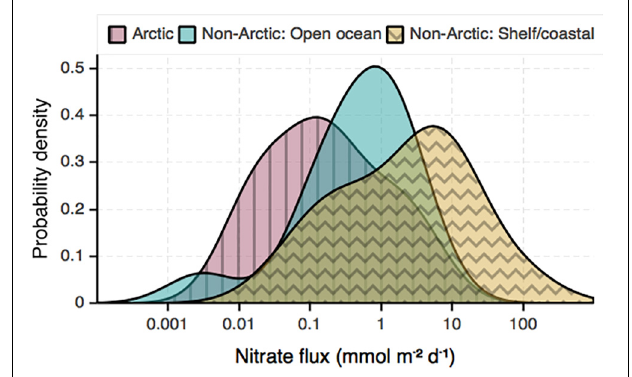
FIGURE 8 | Distributions (kernel density estimates) of observed nitrate fluxes based on Tables 1 , 2 . Note that these curves give each observation the same weight, regardless of areal or temporal